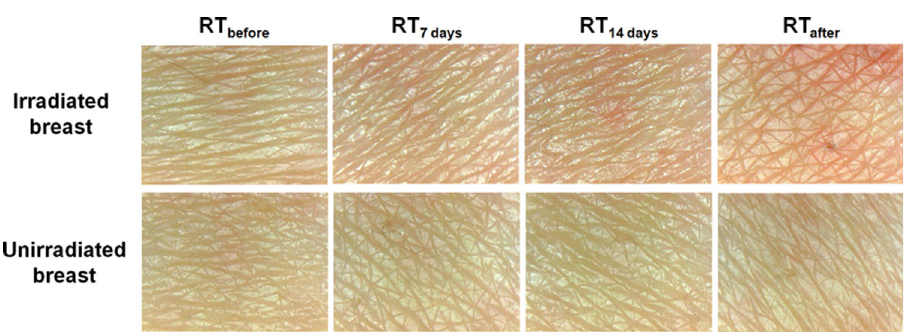
Fig 1. Skin images of both irradiated and unirradiated breasts acquired using a mobile skin analysis device during the course of the experiment. The skin images were acquired before radiotherapy (RT before ), approximately 7 and 14 days after the first fraction of radiotherapy (RT 7 days and RT 14 days ), and approximately 10 days after completion of the radiotherapy (RT after ).